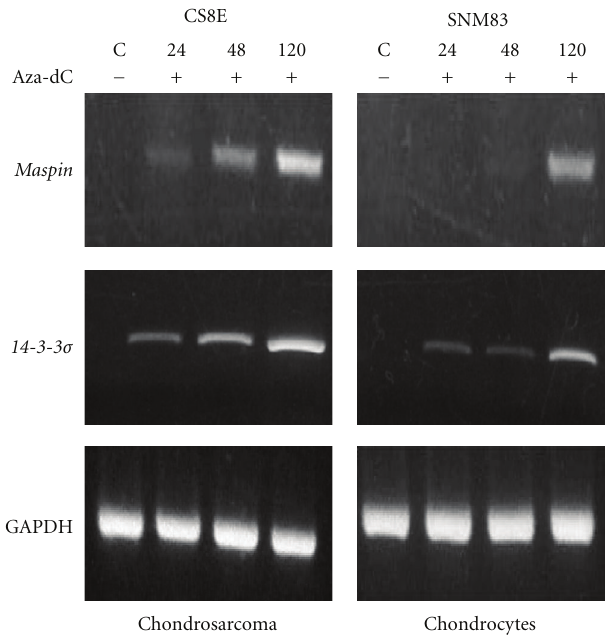
Figure 6: The methyltransferase inhibitor 5-Aza-dC reactivated both maspin and 14-3-3 σ mRNA expression in chondrocytes and chondrosarcomas cell lines. The CS8E chondrosarcoma cell line and SNM83 normal chondrocyte cell line were exposed to 10uM 5-Aza- dC. RNA was harvested after 48, 72, and 120 hours and subjected to RT-PCR for maspin and 14-3-3 σ . GAPDH was used as loading control.